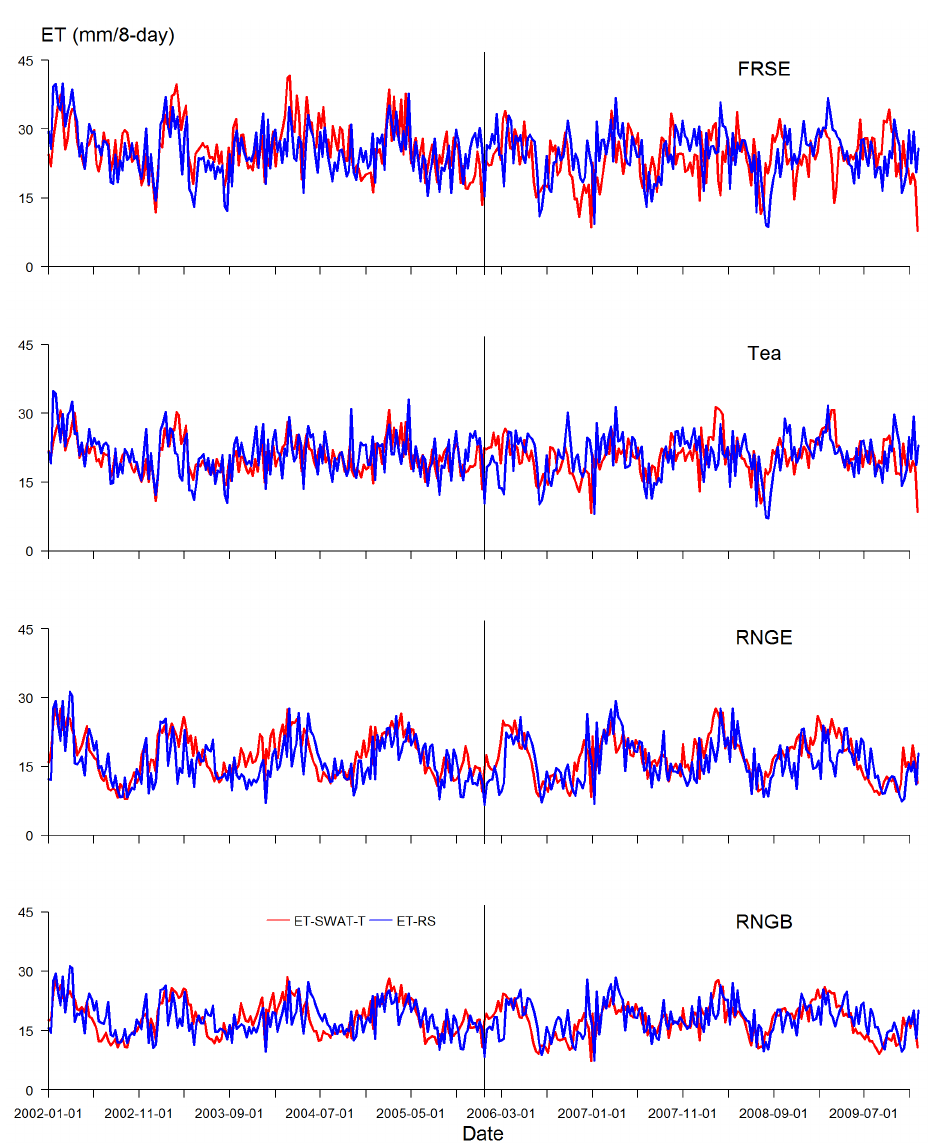
Figure 10. The comparison of remote-sensing-based evapotranspiration (ET-RS) and SWAT-T-simulated ET (ET-SWAT-T) aggregated per land cover class. Note that for SWAT-T HRU level ET is aggregated per land cover. The vertical black lines mark the end of the calibration period and the beginning of the validation